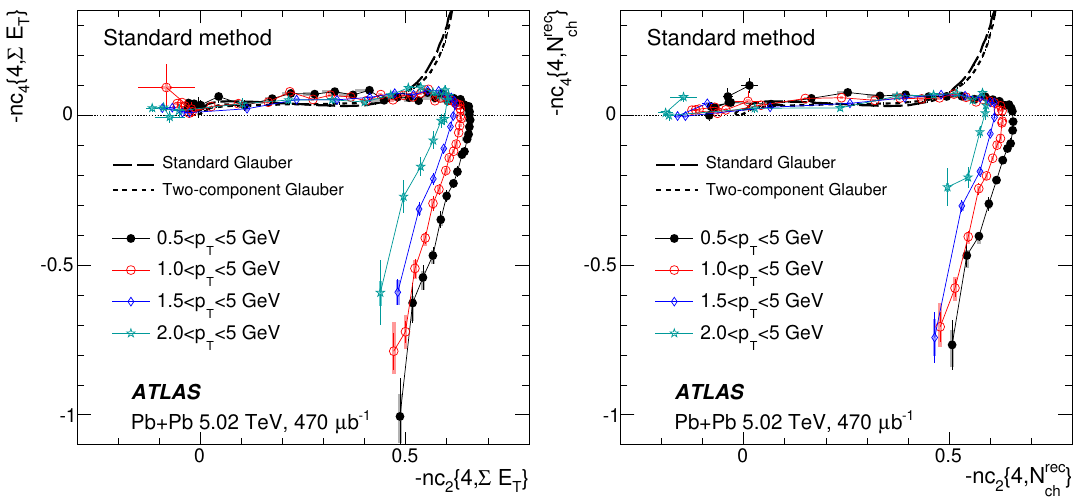
Figure 36 . The correlation between (cid:0) nc 4 f 4 g and (cid:0) nc 2 f 4 g compared with Glauber model predic- tions [41] in four p T ranges with event class based on (cid:6) E T (left panel) and N rec error bars and shaded boxes represent the statistical and systematic uncertainties,